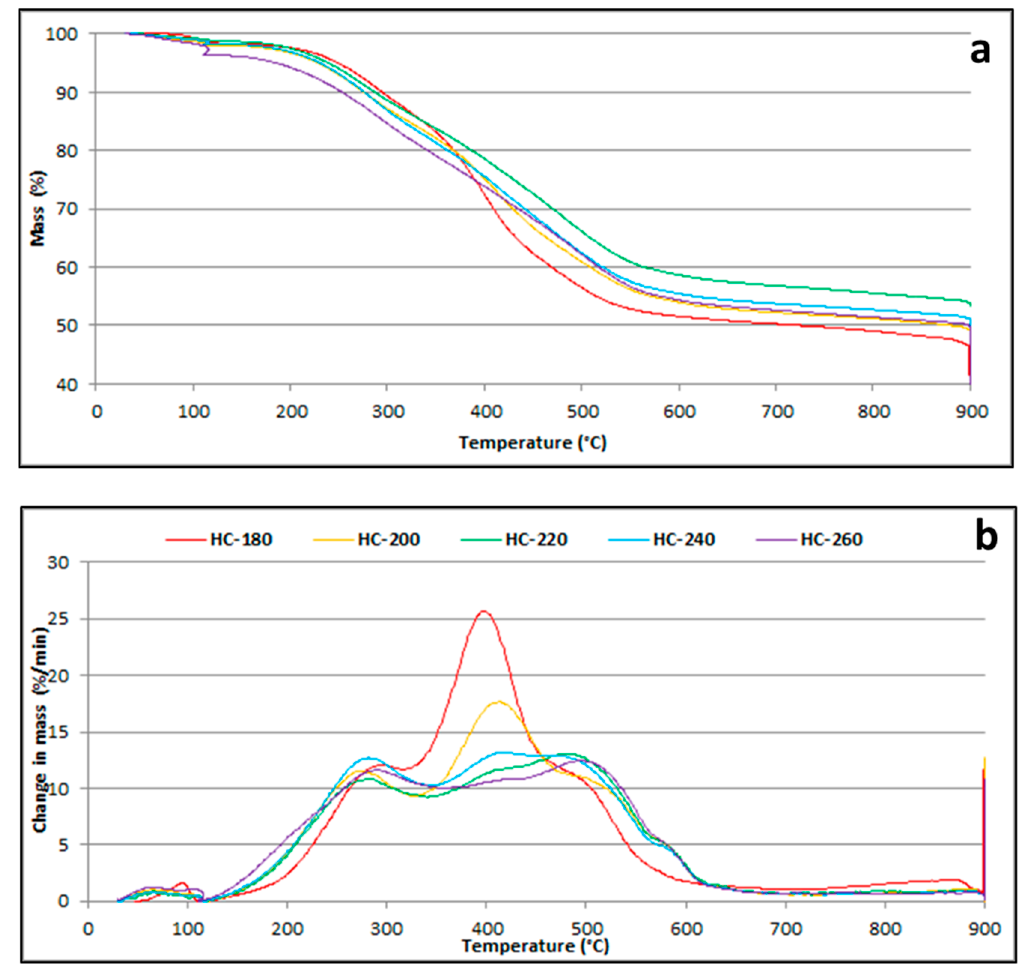
Figure 5. Thermogravimetric (TG) ( a ) and differential thermogravimetric (DTG) ( b ) profiles of hydrochars derived from swine manure.